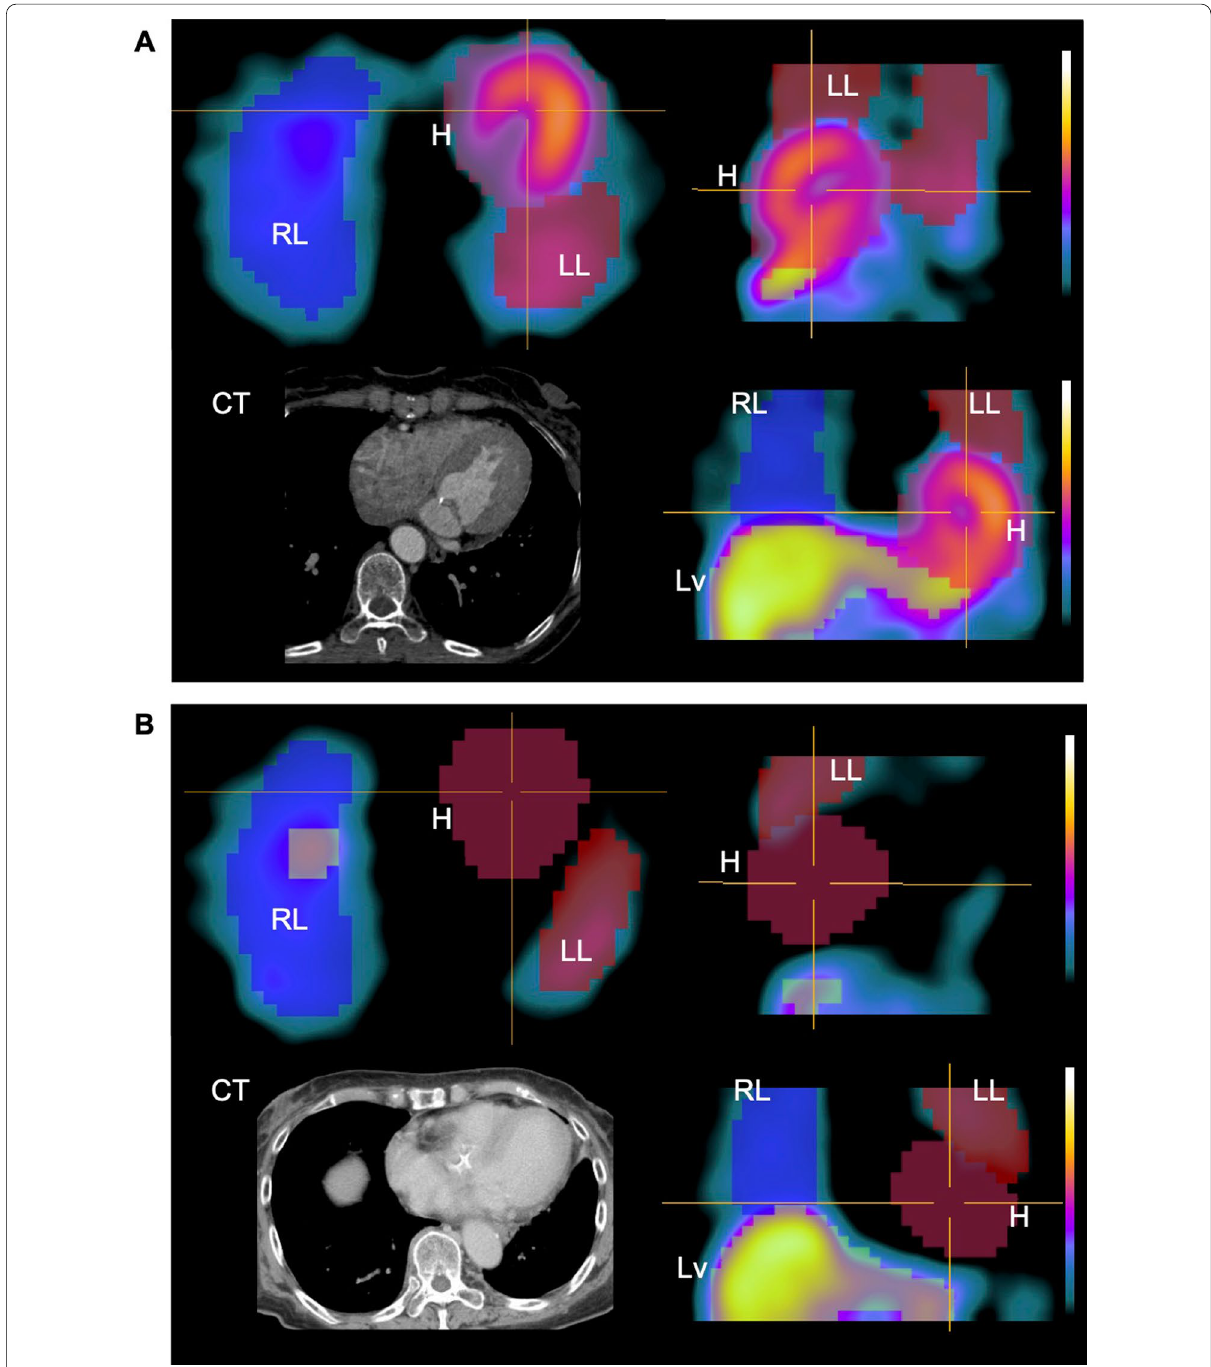
Fig. 2 CNN-based segmentation images with 123 I-MIBG SPECT data. Patients with normal ( A ) and reduced ( B ) uptake. Heart segmentation is correctly identified without anatomical CT images. Liver and lungs are naturally segmented as original organs. Contrast-enhanced X-ray CT images, which were performed for different purposes, are shown as an anatomical reference. H, heart; LL, left lung; Lv, liver; RL, right